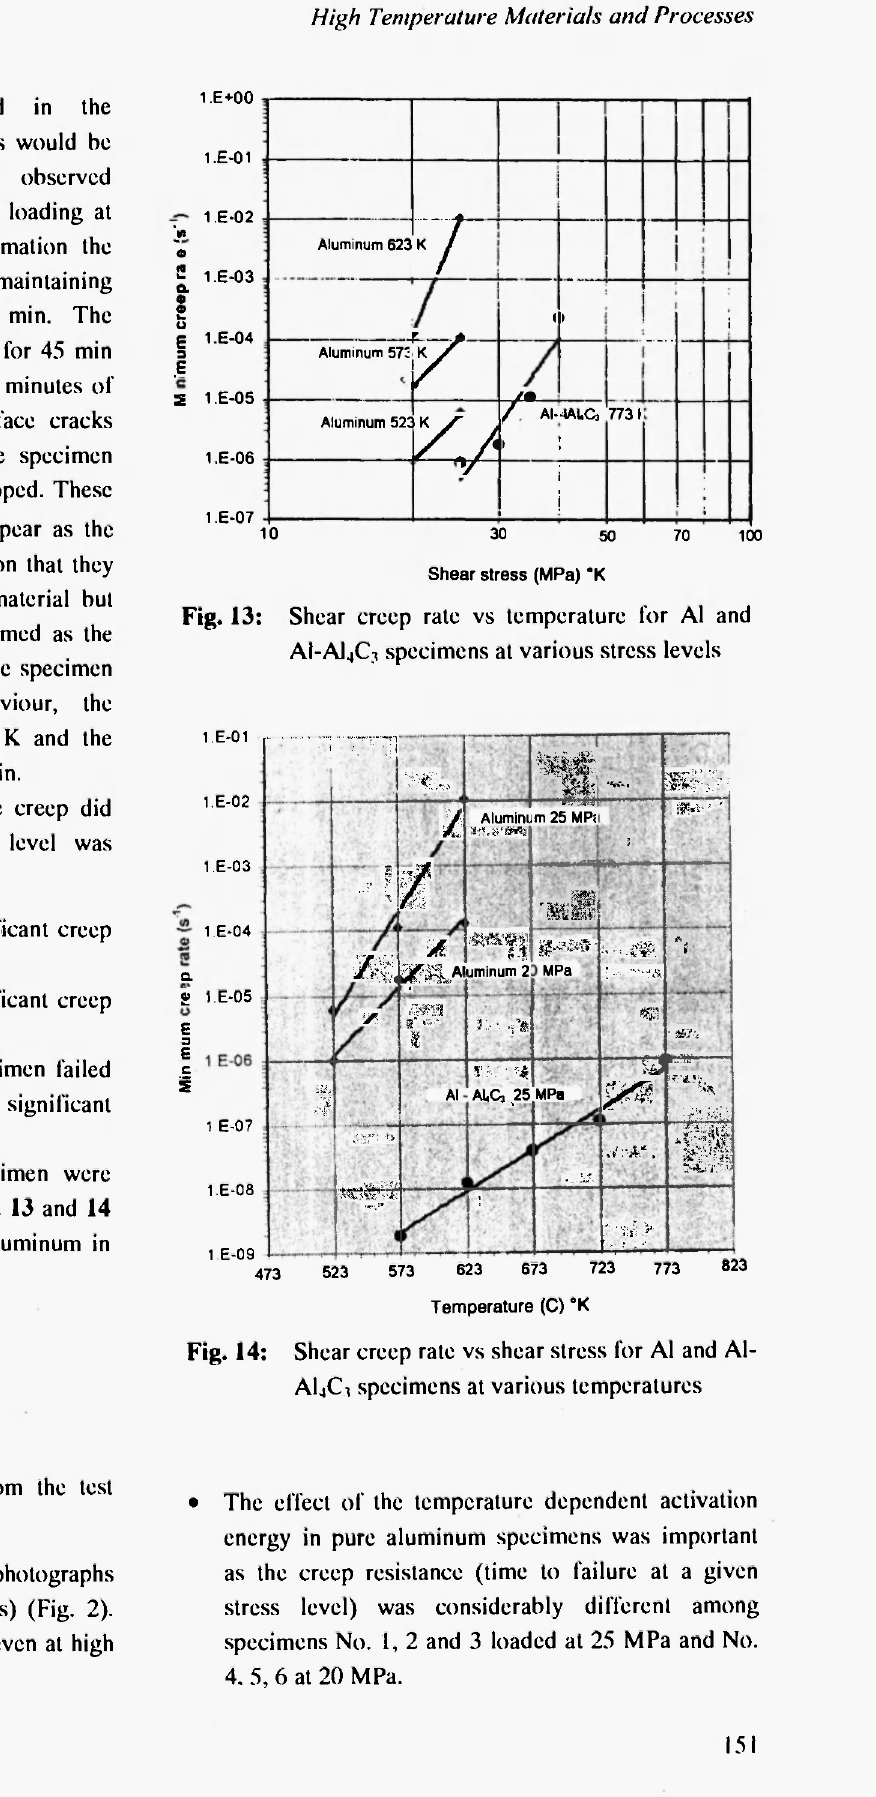
Fig. 14: Shear creep rate vs shear stress for Al and Al- AI4C1 specimens at various